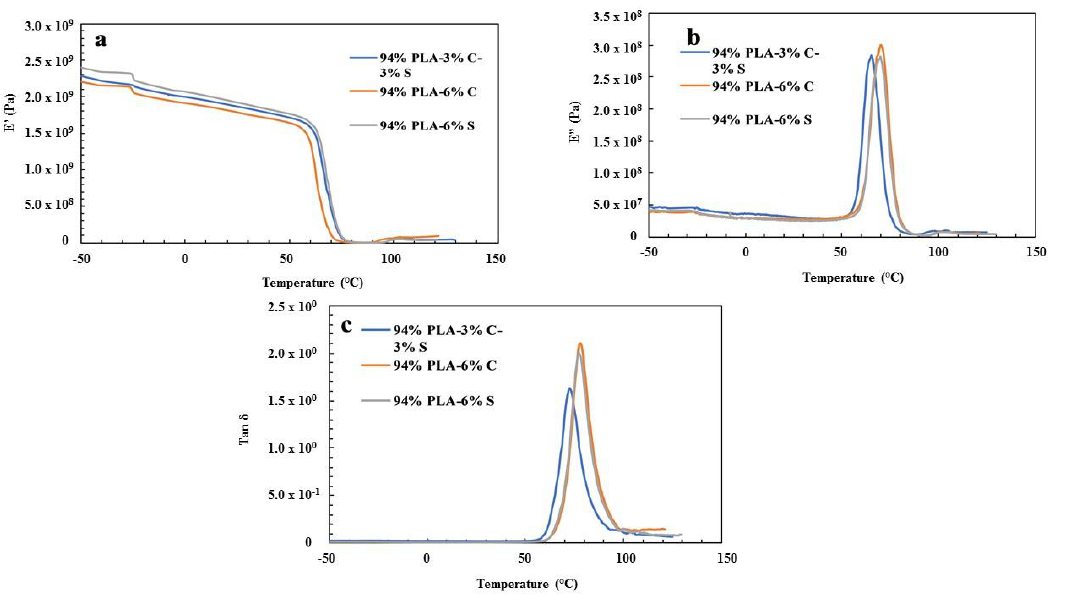
Figure 3. ( a ) Storage modulus (E’); ( b ) loss modulus (E”); ( c ) loss factor tan δ for 94% PLA–3% chitin–3%